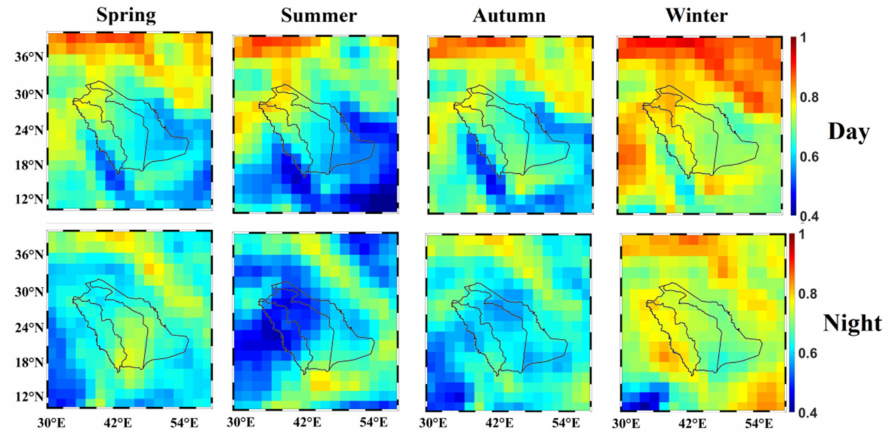
Figure 10. Seasonal spatial distributions of HTH 1 over Saudi Arabia from 2007 to 2019.